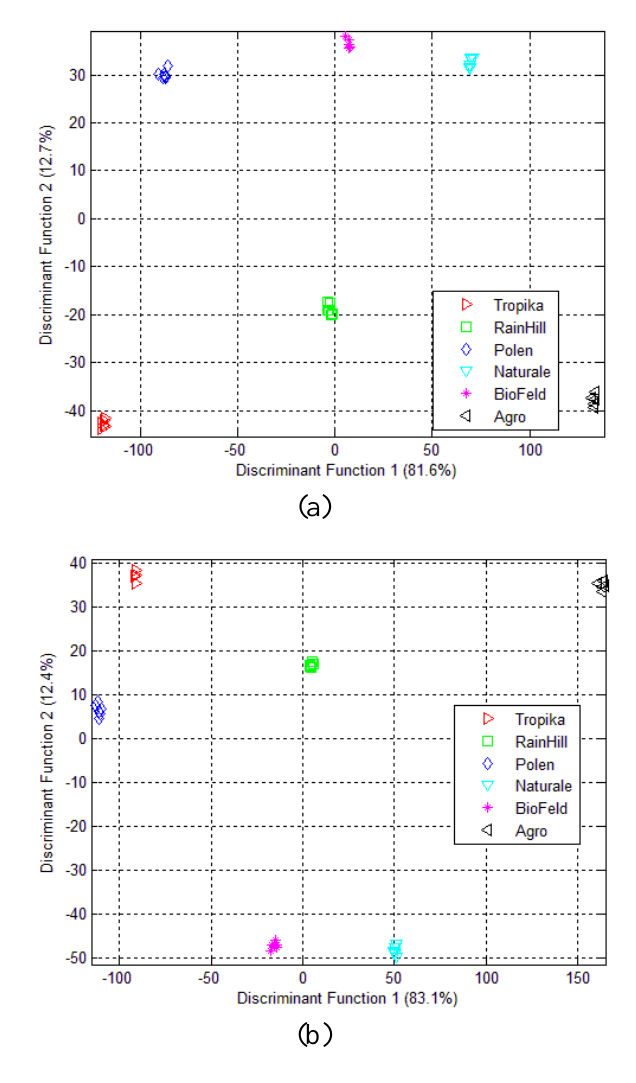
Figure 7. (a) LDA plot for e-nose measurement of dried Orthosiphon stamineus ; (b) LDA plot using e-nose measurement on Orthosiphon stamineus